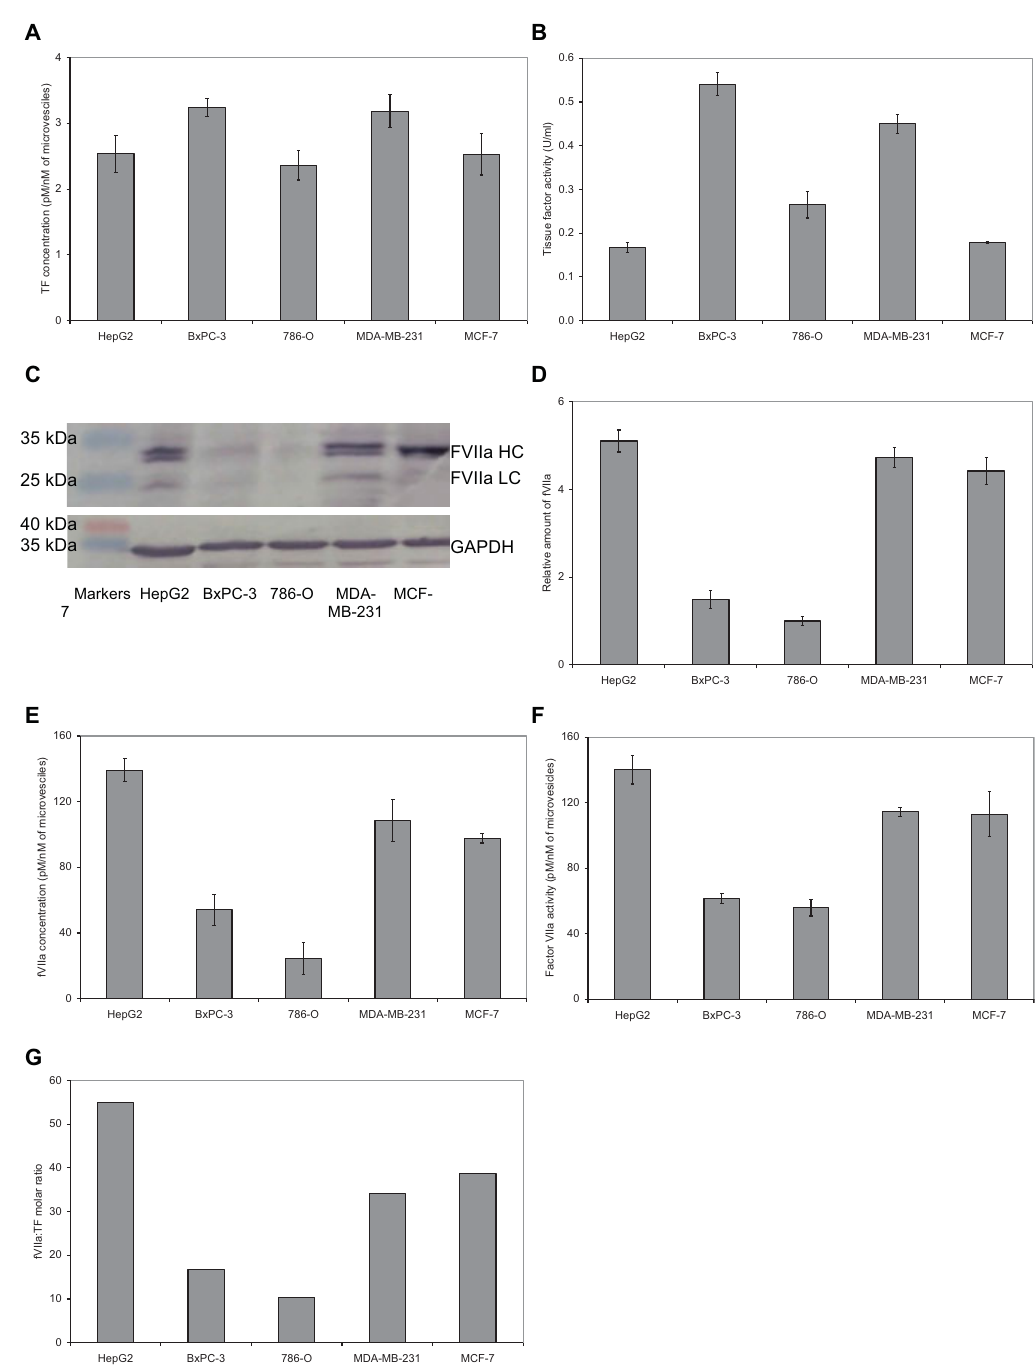
Fig. 1 Analysis of the TFand fVIIa content of microvesicles. Five cell lines (HepG2, BxPC-3, 786-O, MDA-MB-231, and MCF-7) were propagated in 25 cm 2 fl asks,washedwithphosphate-bufferedsaline(PBS)pH7.4andadaptedtorespectiveserum-freemedium,for1hour.Microvesicleswerepreparedfromthe conditionedmediabyultracentrifugationandthefunctionaldensitydeterminedusingtheZymuphenMP-assaykit.( A )TheTFantigenconcentrationof the microvesicles was measured using the Quantikine TF-ELISA kit and ( B ) the associated TFactivities were measured using the fXa-generation assay ( n ¼ 5). ( C )ThepresenceoffVII/fVIIaantigeninthecellswasdetectedbywesternblotanalysis.Thesampleswereseparatedby12%(w/v)SDS-PAGE,transferredonto nitrocellulosemembranesandthenblockedwithTBST(10 mMTris-HCl pH7.4,150 mMNaCl,0.05%Tween-20).Themembraneswerethenprobedwitha rabbit polyclonal anti-fVII antibody diluted 1:2000 (v/v) inTBST and developed with an alkaline phosphatase-conjugated goat antirabbit antibody, diluted 1:4000 (v/v). The bands were visualized using the Western Blue stabilized alkaline phosphatase-substrate and ( D ) quanti fi ed by ImageJ program. (The micrographsarerepresentativeofthreeseparateexperiments).( E )Microvesicle-associatedfactorVII/VIIaantigenlevelswerequanti fi edusingtheAssaymax FVII-ELISAkit( n ¼ 5).( F )Microvesicle-associatedfVIIaactivitywasalsomeasuredbyfXa-generationassaybutintheabsenceofexogenousfVIIaandpresence ofTF(1U/mL)( n ¼ 5).( G )ThemolarratiooffVIIa:TFinmicrovesiclesderivedfromthecellslineswascalculatedusingthedatageneratedabove.SDS-PAGE, sodium dodecyl sulfate polyacrylamide gel electrophoresis; TF, tissue factor.